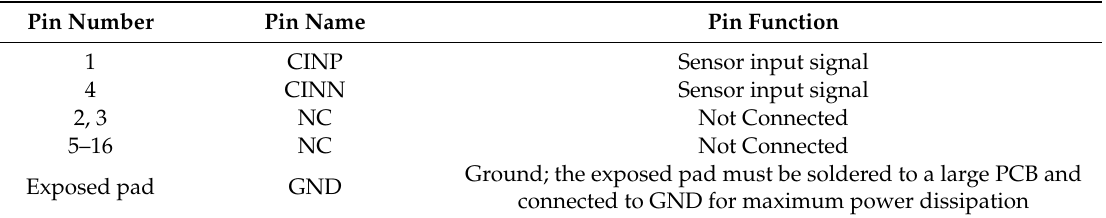
Figure 1. (a) Interdigital electrode is fully symmetric to obtain a uniform measured capacitance from cell distribution on electrodes; the biocell metal spacers, A and B, are explained in Section 2.3; (b) Pin configurations; ( c ) Red ink fills the microfluidic channel. configurations; (c) Red ink fills the microfluidic channel. Table 1. Pin configurations of Table 1. Pin configurations of biocell.